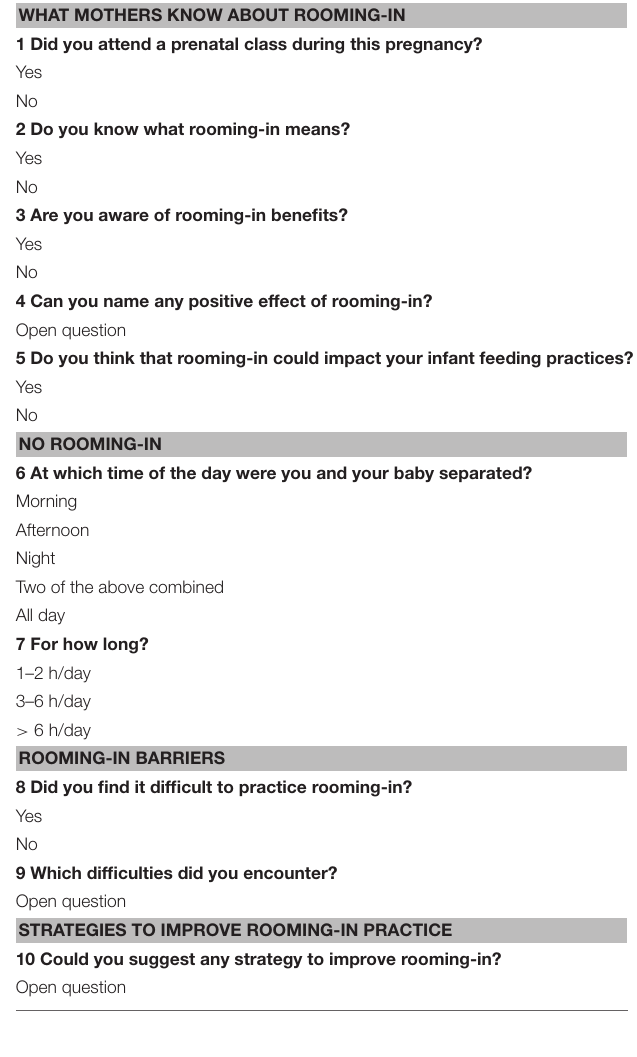
TABLE 1 | Interview investigating maternal knowledge of rooming-in, barriers and strategies. WHAT MOTHERS KNOW ABOUT